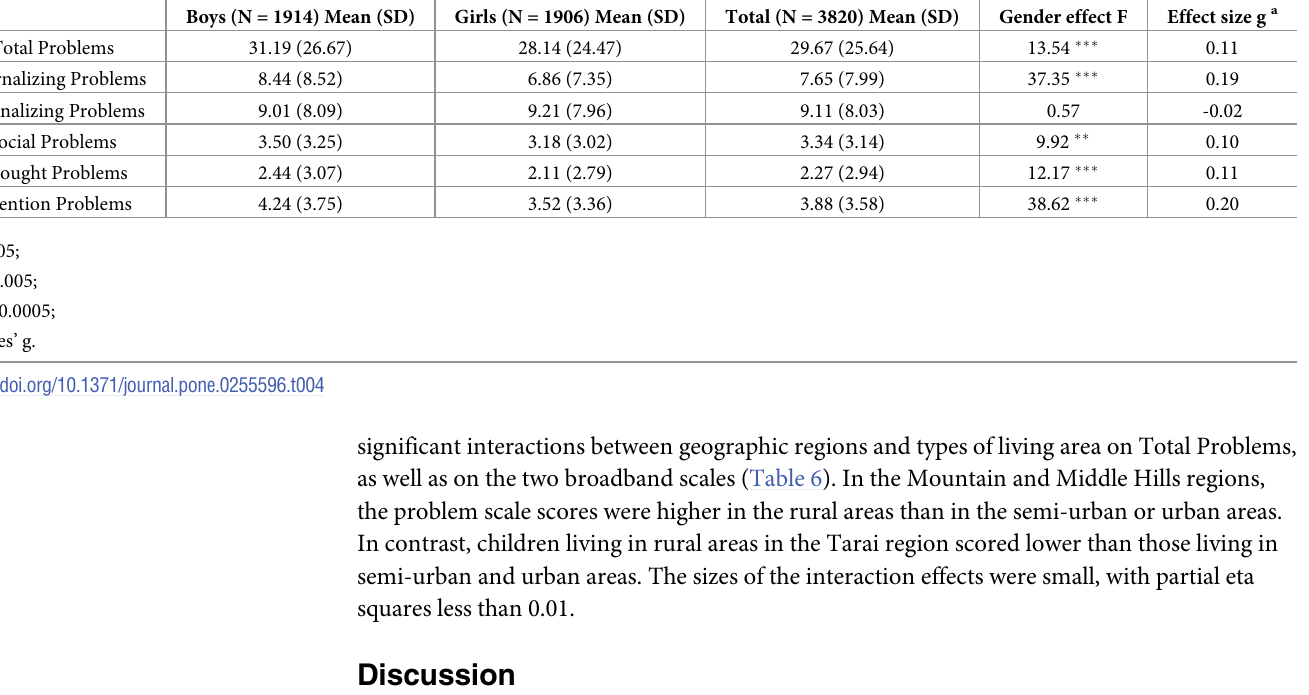
Table 4. The magnitude of EBP for boys and girls–Total sample.